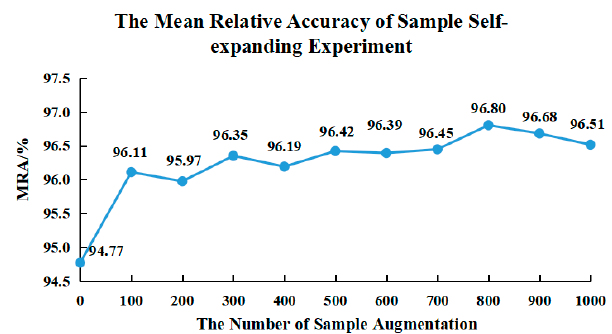
Figure 6. MRA of the results for various numbers of self-expanding samples.